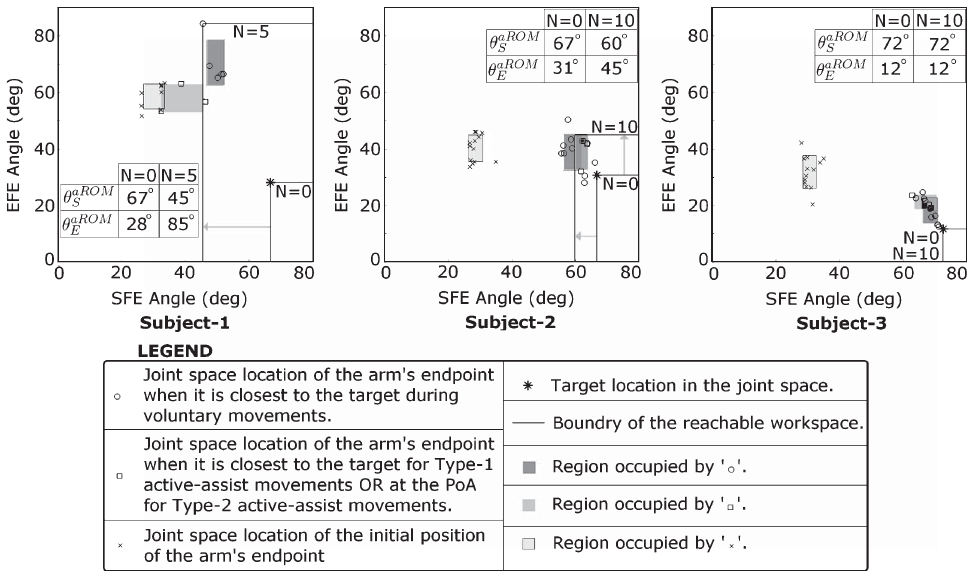
Fig.10. Demonstrationofthelearningofasubject’sreachableworkspaceforAAMreachingmovementstoTarget-2forthethreestrokesubjects.